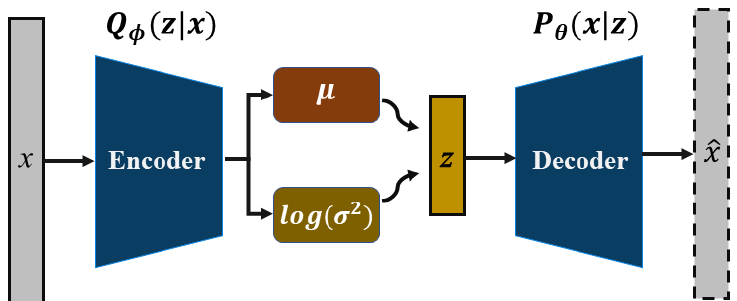
Figure 3. A typical VAE